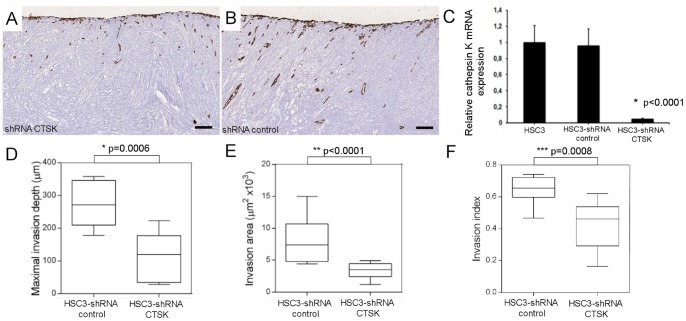
Specific cathepsin K knockdown significantly reduces HSC-3 cell invasion in the myoma organotypic invasion model.The knockdown of cathepsin K mRNA has significantly decreased the invasion of HSC-3 shRNA CTSK cells in the myoma organotypic model when compared with HSC-3 shRNA control cells (A–B). HSC-3 shRNA CTSK cells showed a reduction in cathepsin K mRNA levels when compared with wild type cells and HSC-3 cells transfected with a control shRNA (scramble) *p<0.0001 (C). The invasion depth, invasion area, and invasion index were all significantly reduced for HSC-3-shRNA CTSK cells (*p = 0.0006, **p<0.0001, and ***p = 0.0008, respectively) (D–F). Scale bars 200 µm.